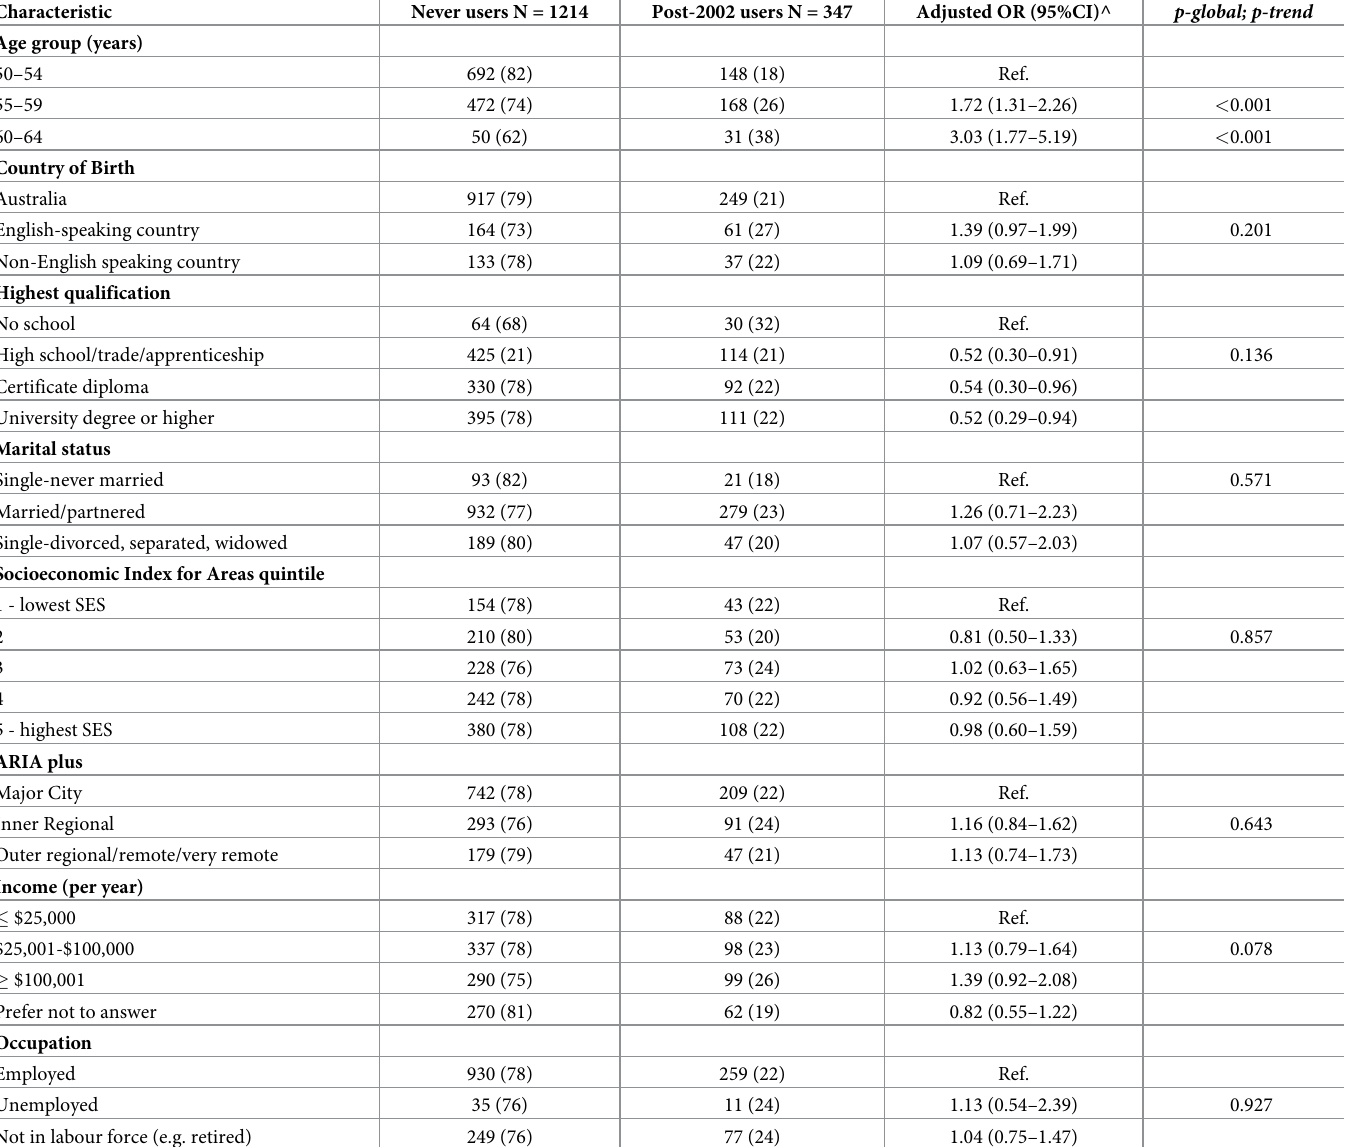
Table 1. Associations between socio-demographic characteristics and menopausal hormone therapy use between users initiating MHT after 2002 and never users (younger than 50 in 2002) among Australian women aged 50–69 years old.